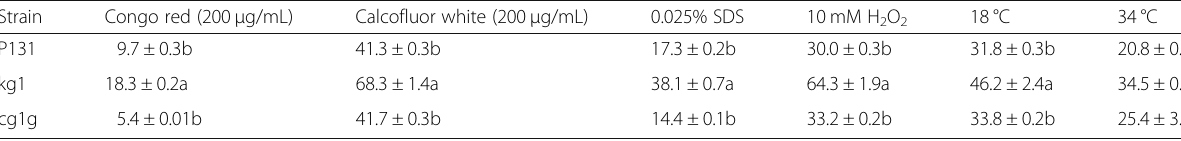
The inhibition ratio=((diameter on CM – diameter on amended medium)/(diameter on CM))×100. The mean±SD was calculated based on three independent experiments measuring three plates in each replicate. Different letters are used to mark statistically significant differences using one-way analysis of variance (ANOVA) and subsequent Tukey ’ s post hoc test ( P